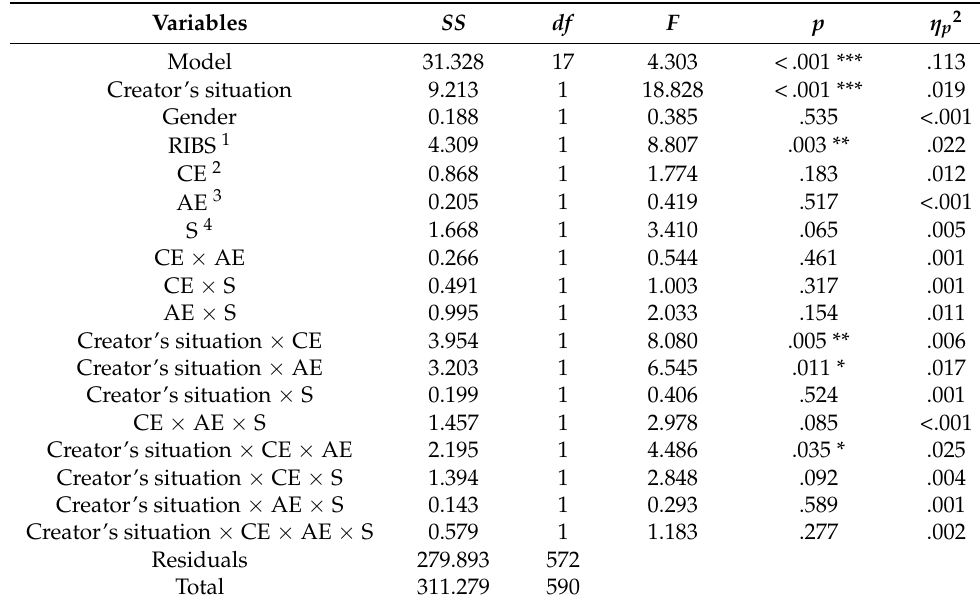
Table 2. The effects of the creator’s situation, gender, RIBS, empathy, and their interactions with creative product